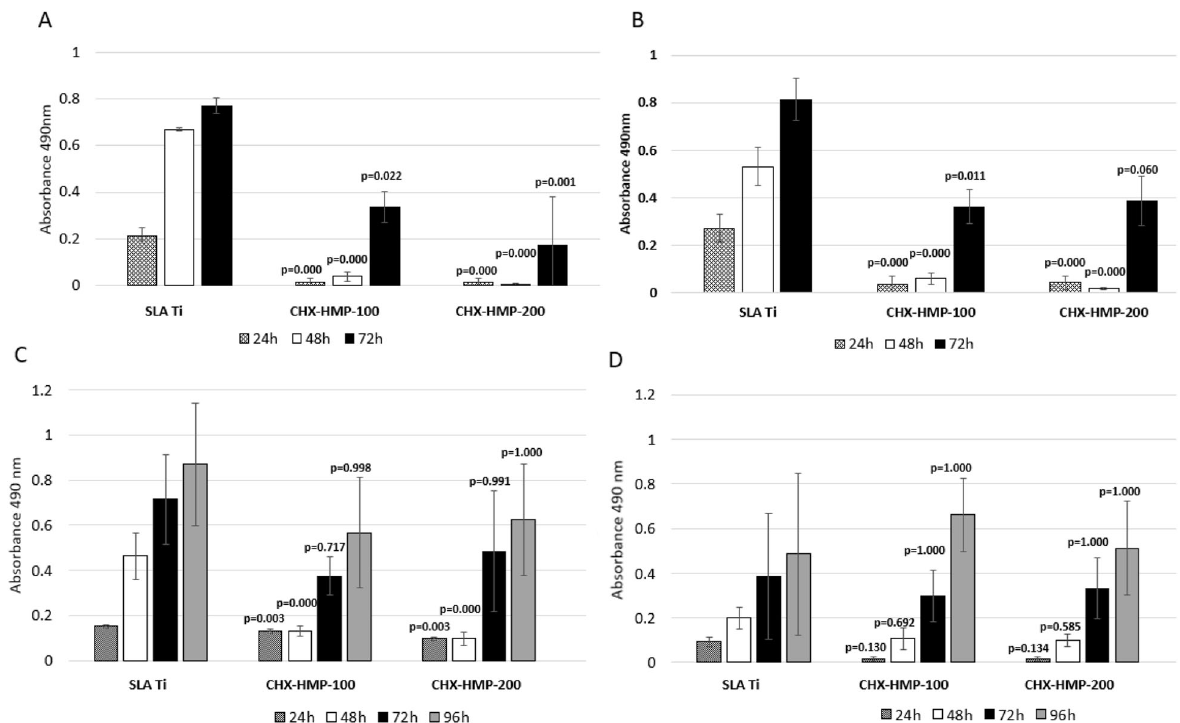
Fig. 3 Biomass of bio fi lms grown on uncoated and CHX-HMP coated 24 h. Biomass was quanti fi ed by safranin stain and acetic acid release. Error bars represent standard deviations. P -values are shown relative to SLA Ti. Bio fi lms were formed using bacterial inocula of 0.5 × 10 4 CFU ( A , C ) or 0.5 × 10 7 CFU ( B , D ), and grown for 72 h ( A , B ) or SLA Ti surface as determined by 1-way ANOVA with Sidak correc- 96 h ( C , D ), the latter including a re-inoculation step with S. mitis after tion post hoc ( n = 3) Table 3 Mean percentage composition of 72-h multispecies bio fi lms formed on SLA Ti and CHX-HMP coatings Mean % of each species within total bio fi lm a Coating and inoculum S. mitis F. nucleatum